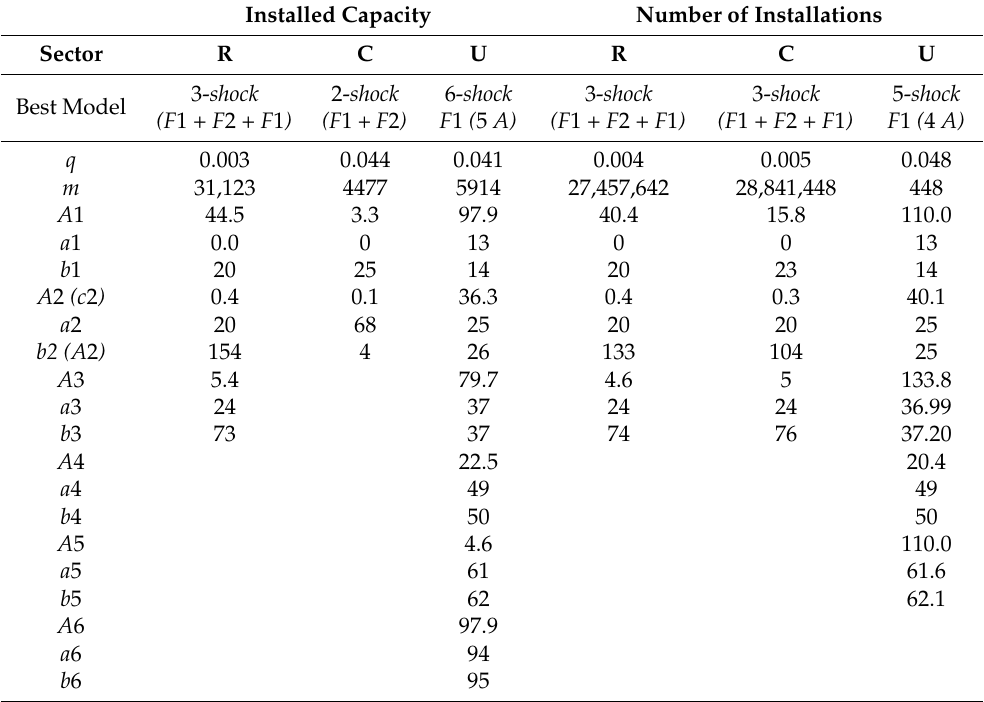
Table 1. Estimates of GIM parameters for the time series of PV adoptions in the UK 2010–2021 for the three sectors considered: residential (R), commercial (C), and utility (U) and for the two types of data series considered (by installed capacity and by numbers of installations). For each of the six categories considered, the best-fit model is reported including the estimates of the basic Bass parameters ( q , m ) as well as the type and number of shocks, e.g., “2-shock ( F 1 + F 2)” means that two shocks having forms F 1 and F 2 were selected, while 5-shock F 1 (4 A ) refers to 5 rectangular shocks (form F 1) estimated with 4 different intensities ( A